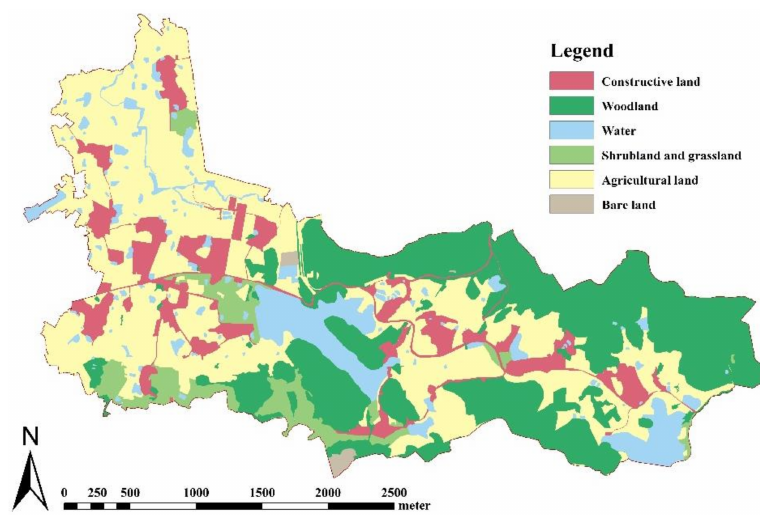
Figure 4. Land use of Paifang Village in